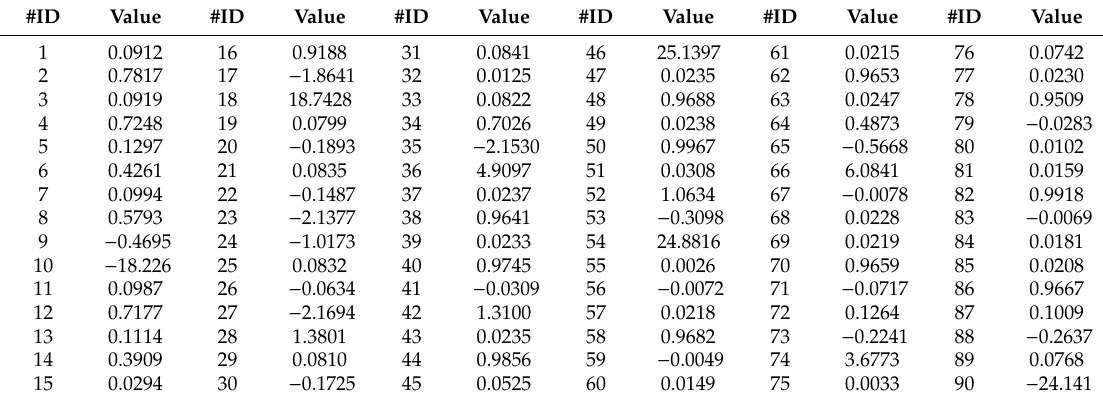
Table 4. Optimized parameters of the ANFIS model for the second test network during tuning of Table 1. parameter.